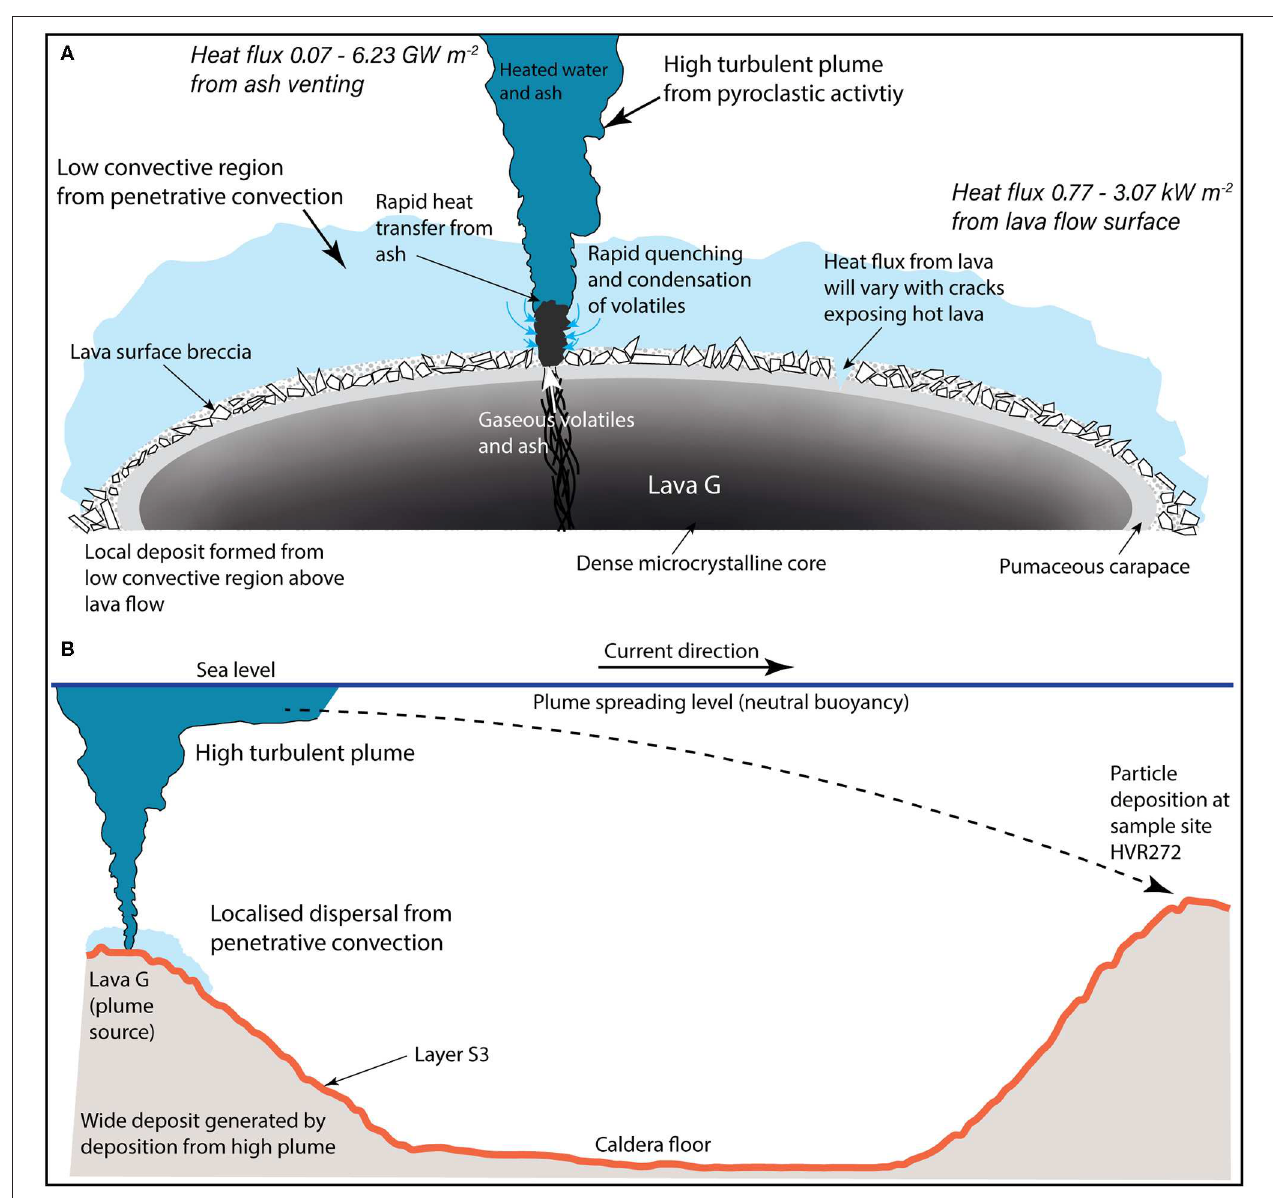
FIGURE 12 | Schematic model of eruption processes S3. (A) Lava G being erupted onto the sea floor. Heat flow from the lava surface to the ambient water column is relatively low due to the formation of an insulating quenched carapace and overlying breccia. The low rate of heat transfer drives weak penetrative convection above the lava flow forming a convecting region up to about 200m thick, shown in light blue. Syn-extrusive pyroclastic activity driven by outgassing through tuffesite networks forms a small jet of volatiles and ash that rapidly condenses and quenches on contact with the ambient water. Rapid heat transfer from the jet to the ambient water drives a buoyant turbulent plume that would reach the sea surface, shown in dark blue. (B) A wider view of the dispersal process. Particles entrained in the buoyant turbulent plume are dispersed in a lateral current to form the observed seafloor deposit of S3. Localized dispersal of fine ash occurs as a result of penetrative convection likely forming a minor component of the overall deposit.